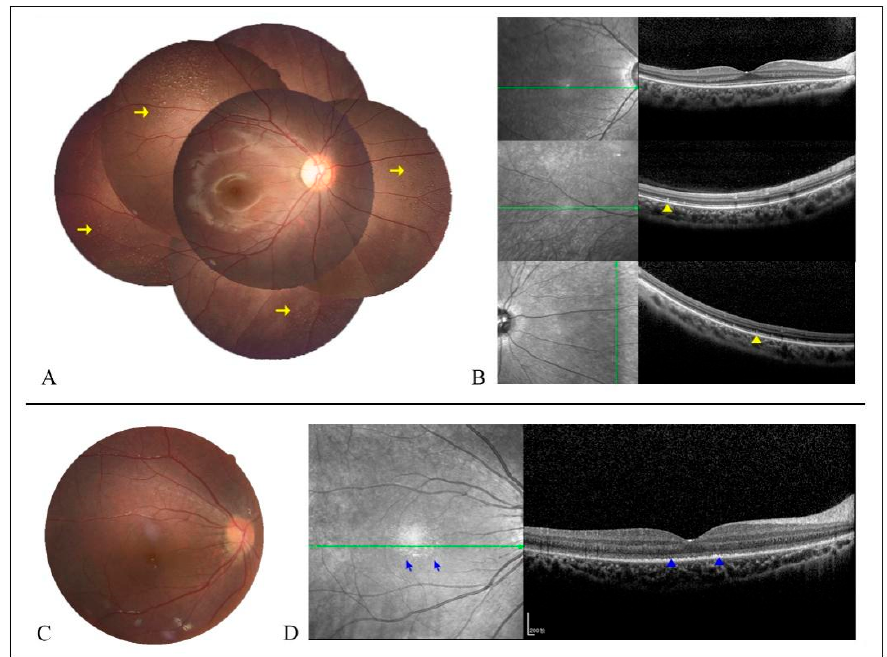
Figure 4. Colored fundus (CF) images and OCT scans in patients 0191010 ( A , B ) and 0191577 ( C , D ). ( A ) CF image shows abundant white dots (WDs) in the mid-peripheral and peripheral retina (yellow arrow). ( B ) OCT scans display hyperreflective remnants (yellow triangle) corresponding to the WDs. ( C ) CF photography shows an almost normal fundus appearance. ( D ) Infrared fundus image reveals multiple drusen-like fine granular dots in the fovea (blue arrow), which presented as a diffuse hyperreflective substance in the retinal pigment epithelium (RPE) layer in the OCT image (blue triangle).